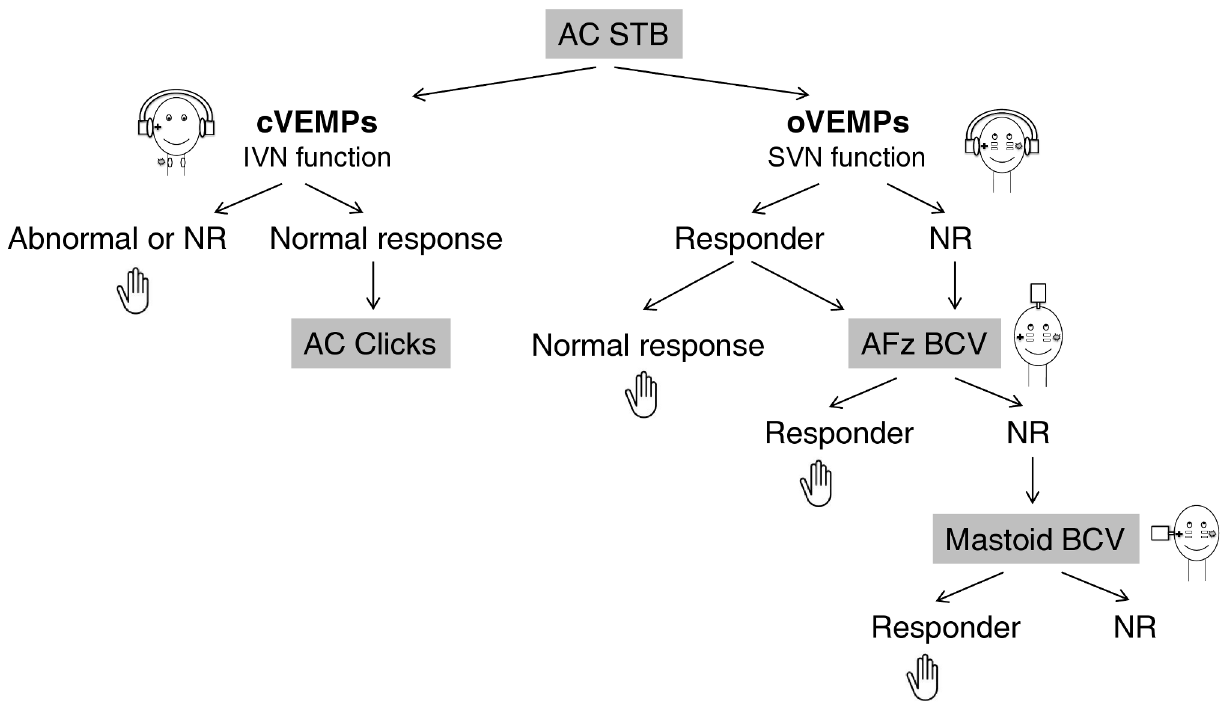
Figure 4. Flowchart illustrating in which order the stimulations (ACS and BCV) should be done to test predominantly the function of the superior and mostly of the utricular nerve using oVEMPs. IVN: inferior vestibular nerve - SVN: superior vestibular nerve. ACS stimulation may be performed first in patients suffering from vertigo. If ACS induced normal oVEMPs, BCV was not required. If ACS gave abnormal oVEMPs, bone stimulation should be done. We suggest beginning with AFz BCV stimulation: this mode stimulates both labyrinths equally and is easier to perform than mastoid stimulation in a routine clinical setting. When no response was observed on either side to ACS and to AFz stimulation, mastoid BCV stimulation is necessary to appreciate the residual function of the superior vestibular